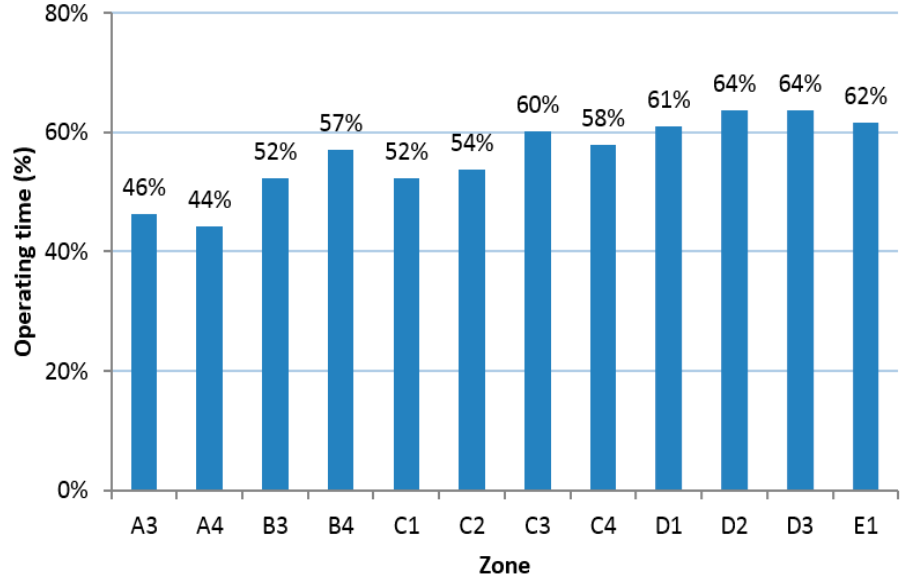
Figure 14. Annual operating time.